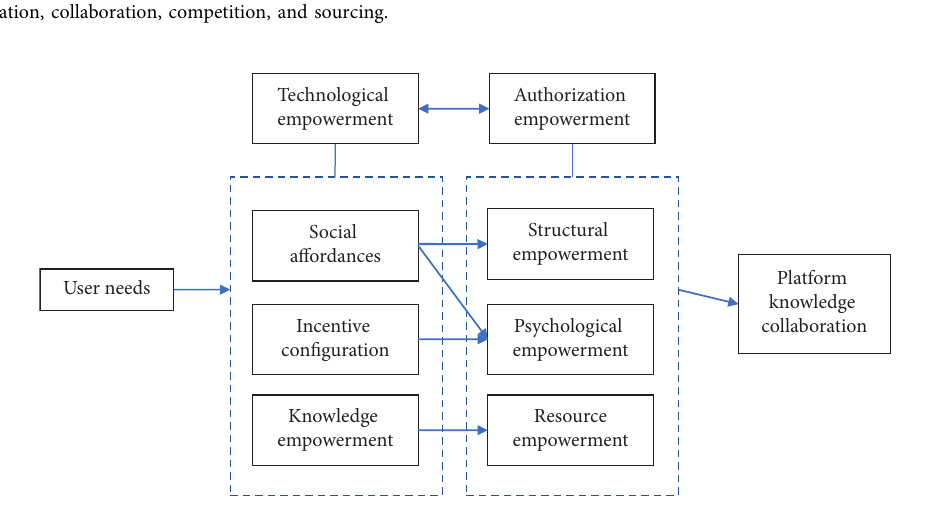
Figure 1: Research on the empowerment mechanism based on